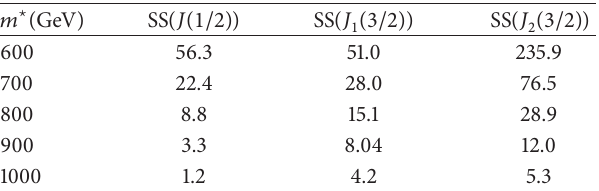
Table5:StatisticalsignificanceSSfor 𝑒𝑝 colliderwith √𝑠 = 1.98 TeV for excited spin-1/2 neutrinos and excited spin-3/2 neutrinos with 𝐽 1 and 𝐽 2